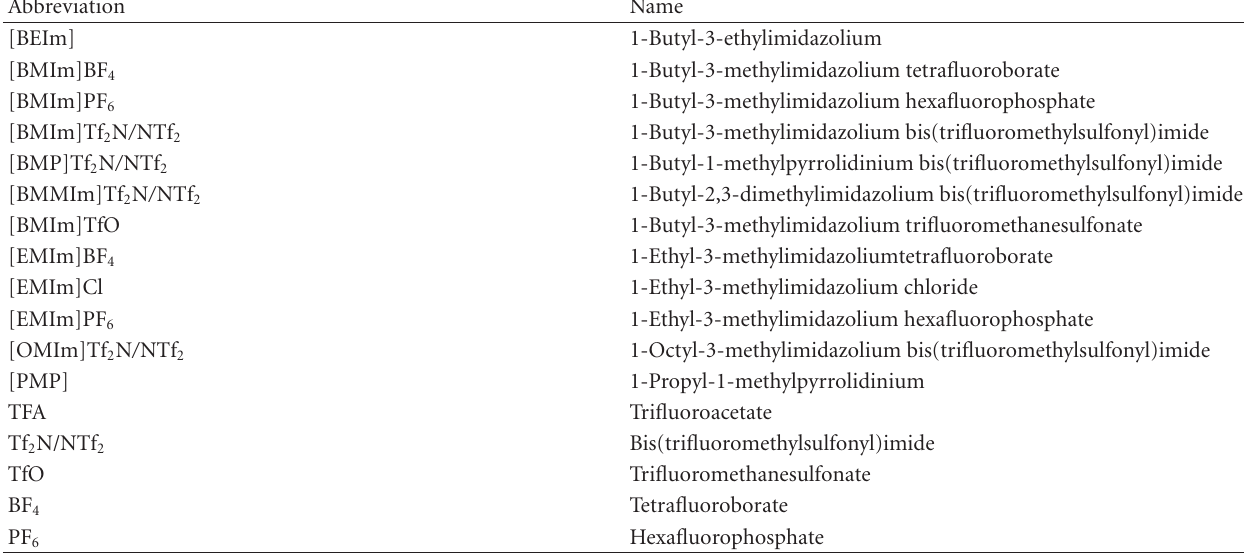
Table 1: List of some